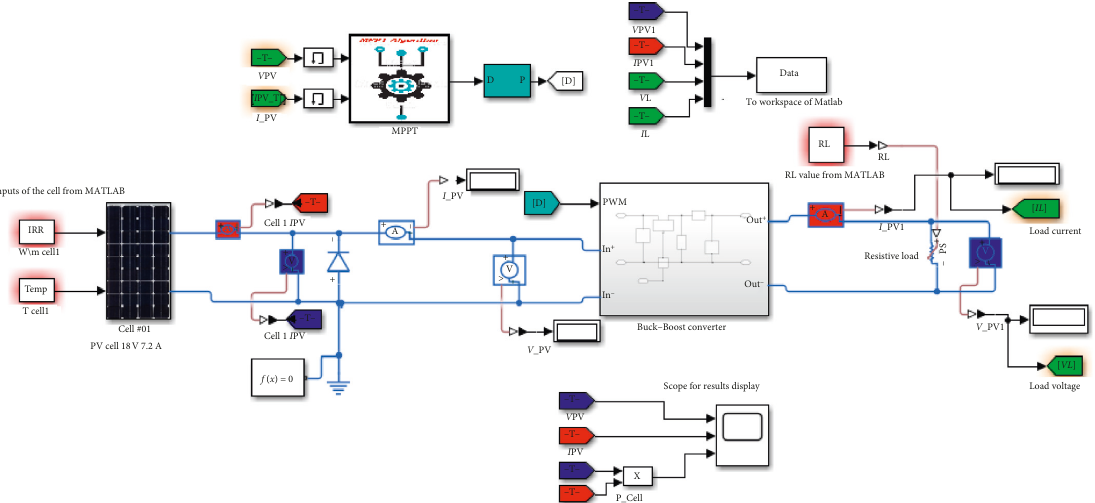
Figure 1: Complete PV system model using MATLAB and Simscape.